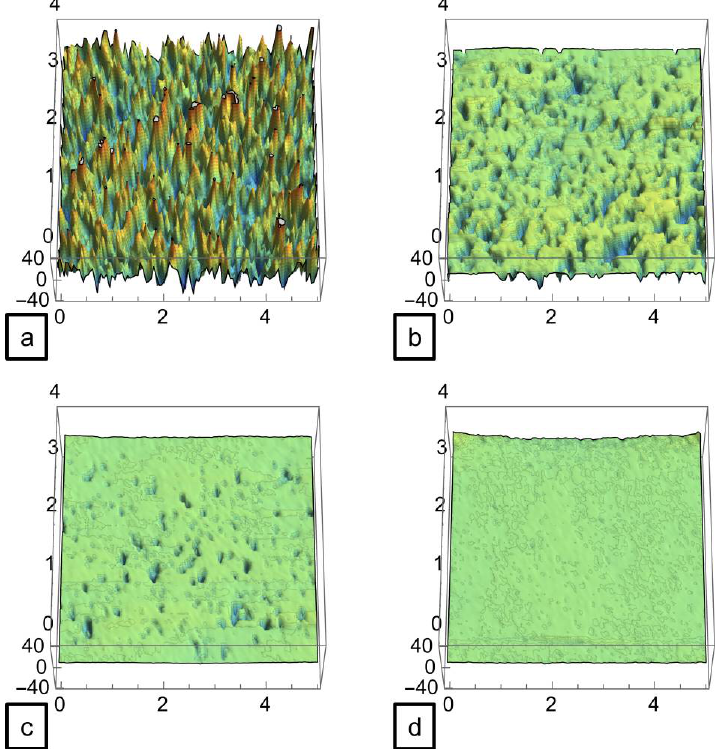
Figure 11. 3D maps of 90° building orientation surfaces before BF ( a ), after 12 h ( b ), after 24 h ( c ), and after 48 h ( d ) working time.